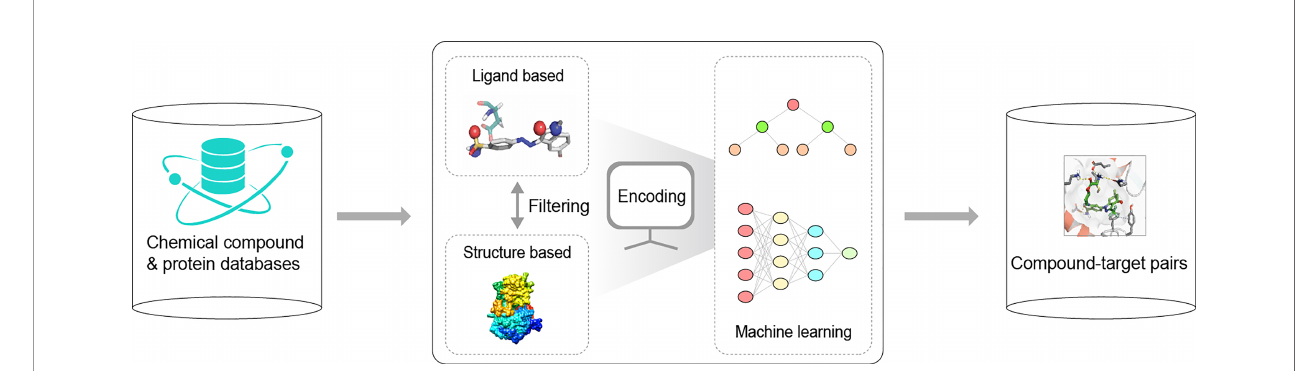
FIGURE 5 | A basic work fl ow for virtual screening platform in the process of drug discovery. In this process, machine learning represents a powerful tool to predict compound-target pairs using compound datasets and functional known